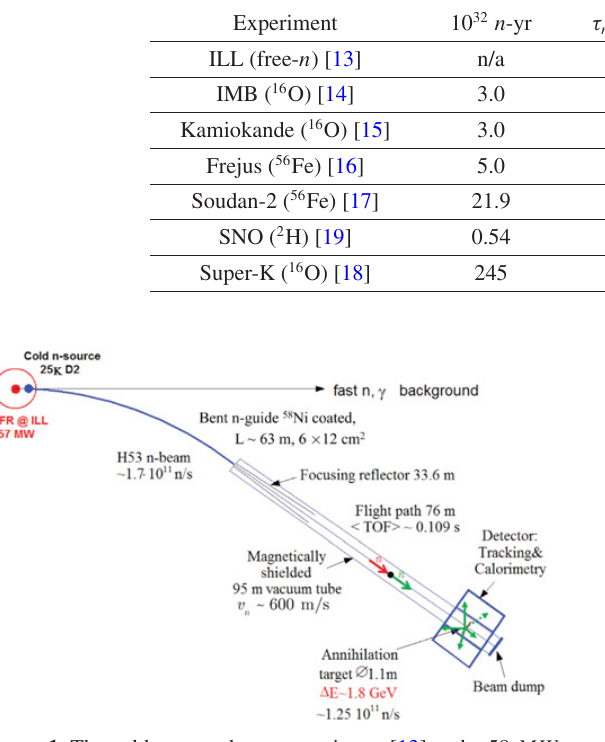
Figure 1. The cold neutron beam experiment [13] at the 58 MW research reactor at the Institut Laue Langevin in Grenoble. This experiment set the most stringent limits to date for neutron– antineutron transformations in free